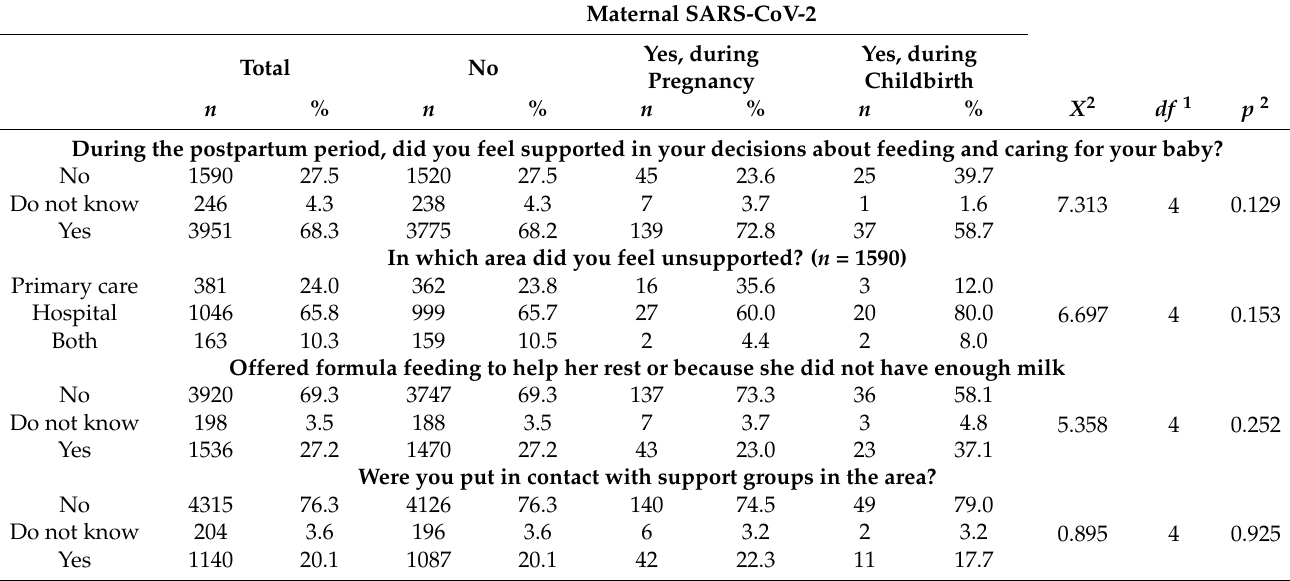
Table 4. Comparative analysis of breastfeeding variables and the diagnosis of maternal